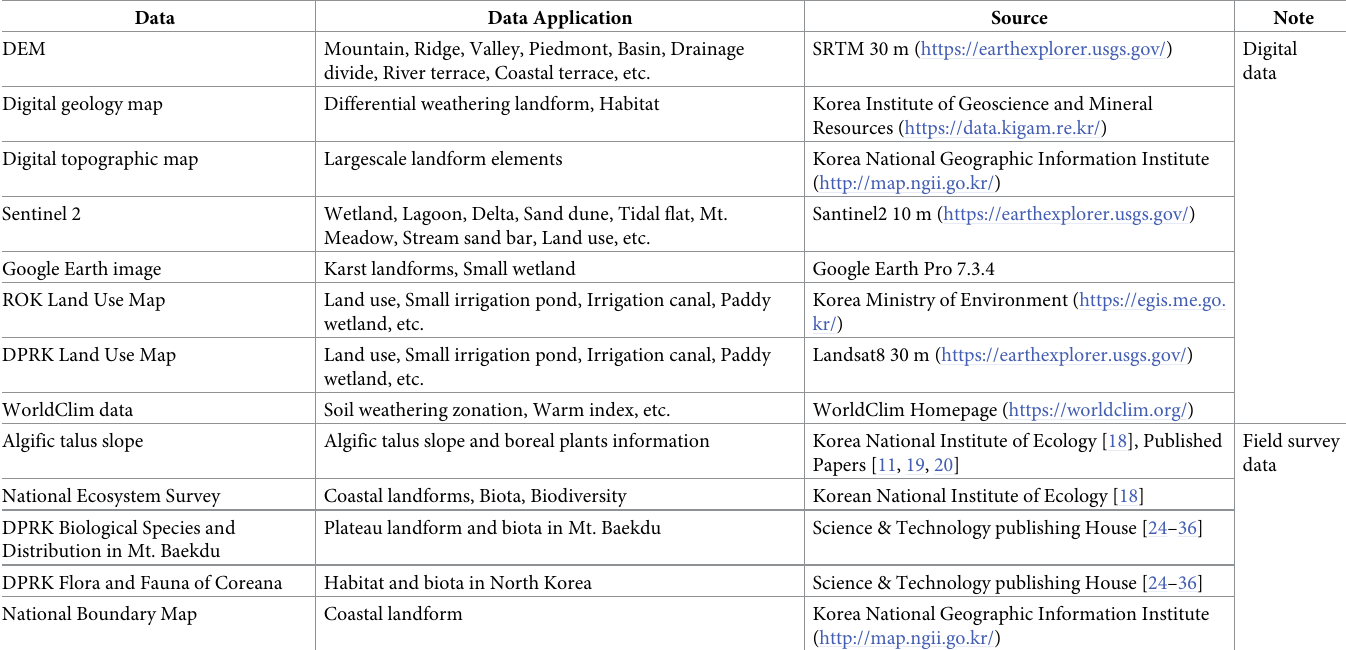
Table 7. Data types for landform